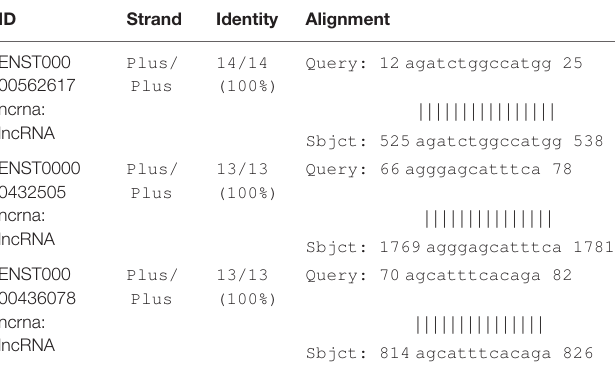
CNTN4 , the rs10260404 in DPP6 , and the rs79609816 in INPP5B were markedly associated with sALS in the HACM population.